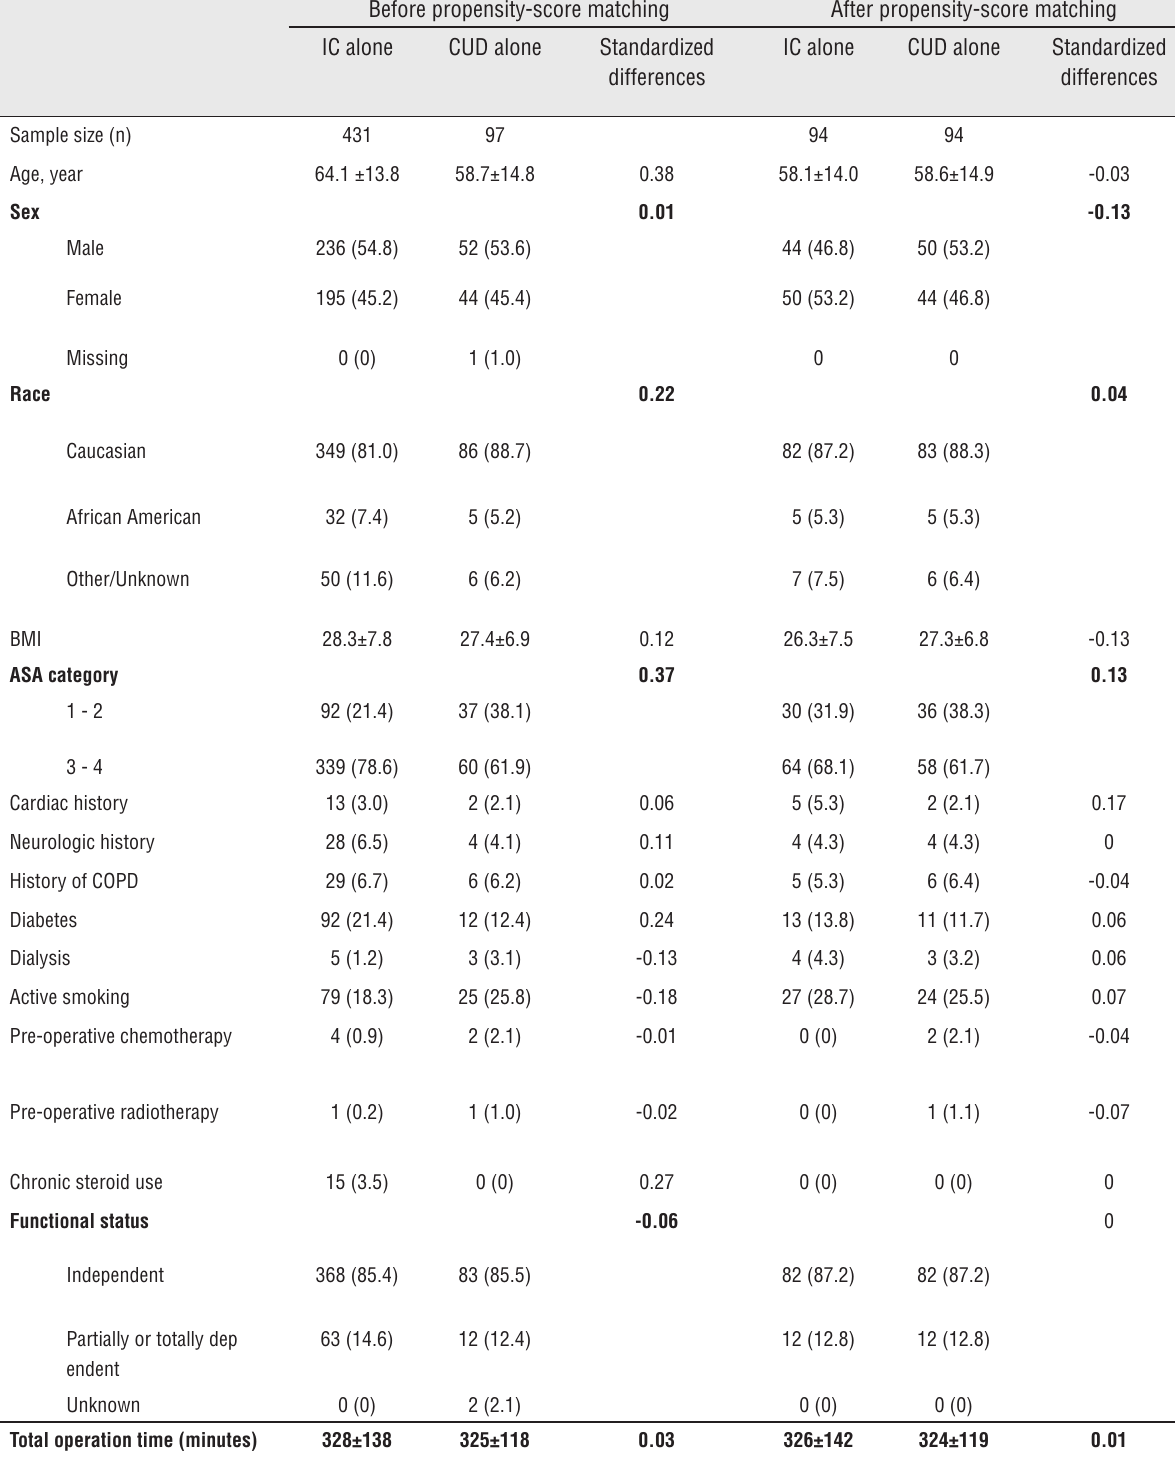
Supplemental Table 3 - Baseline characteristics of patients before and after propensity-score matching for IC alone vs CUD